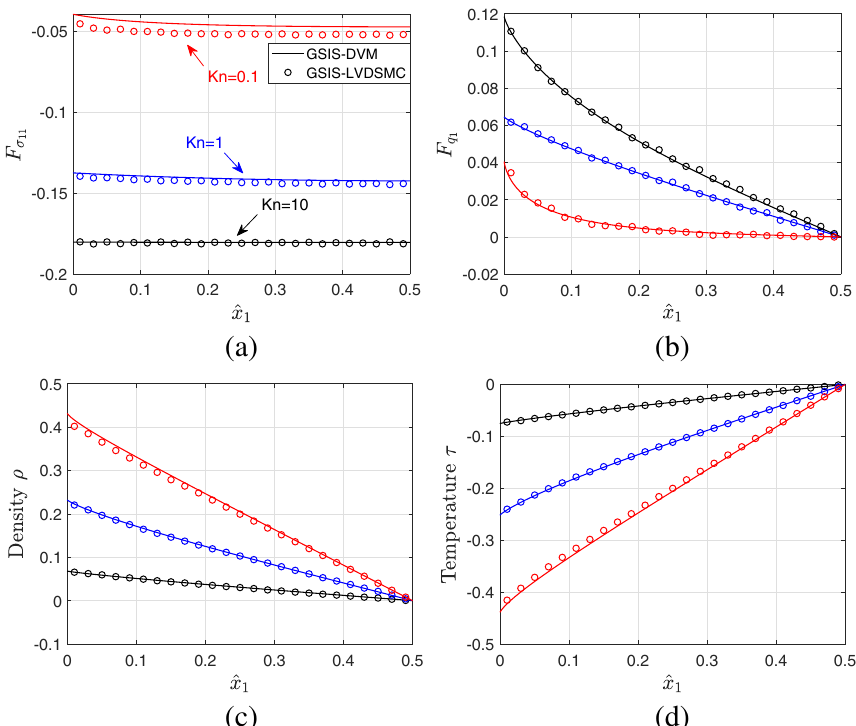
Fig. 9 The time-averaged properties obtained from GSIS-LVDSMC (lines) are compared to the reference solution from GSIS-DVM (circles). a F σ associated with the high-order term of stress, b F q 11 high-order term of heat flux, c the perturbed density and d the perturbed temperature of planar Fourier